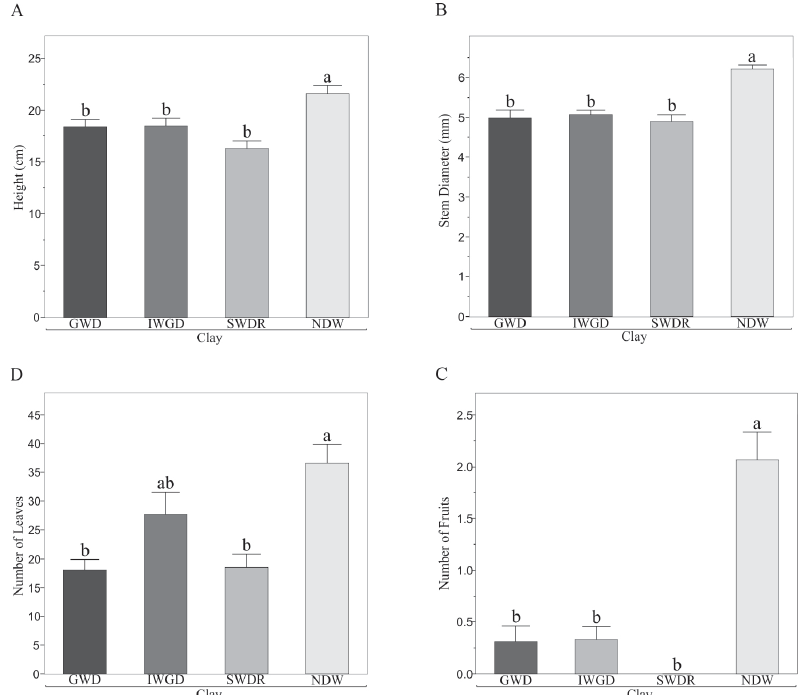
Figure 7. Performance of chili pepper plants grown in clay soil with different irrigation regimes. Results of the comparison of means ± S.E. by using Tukey ′ s test of the morphological variables. ( A ) Height; ( B ) Stem diameter; ( C ) Number of leaves; ( D ) Number of fruit. In all cases, p = 0.05. Gradual water deficit (GWD), initial waterlogging with gradual water deficit (IWGD), sudden water deficit with gradual recovery (SWDR), no deficit of water (NDW).